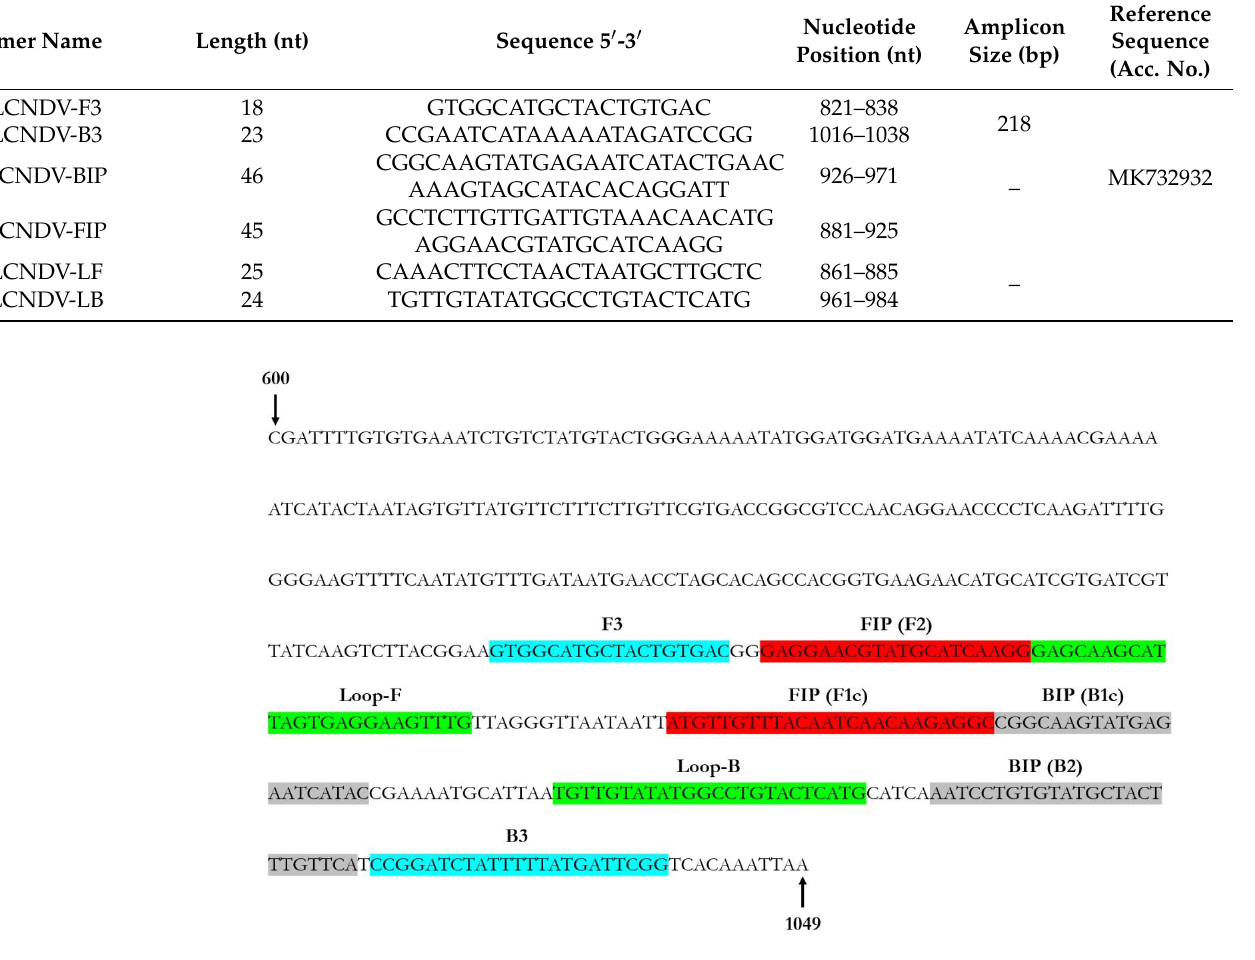
Figure 1. Loop-mediated isothermal amplification (LAMP) primer set location designed on the ToLCNDV-AV1 coding region. F3 and B3 are shown in pale blue, FIP (F1c-F2) in red, BIP (B1c-B2) in grey, and the two loop primers LF and LB in green. FIP is a hybrid primer consisting of the F1c and the F2 sequences, while BIP is a hybrid primer consisting of the B1c and B2 sequences. The numbers at the beginning and end of the sequence represent the genomic position of the first and last nucleotide in the selected ToLCNDV DNA-A complete sequence (GenBank Acc. No. MK732932).